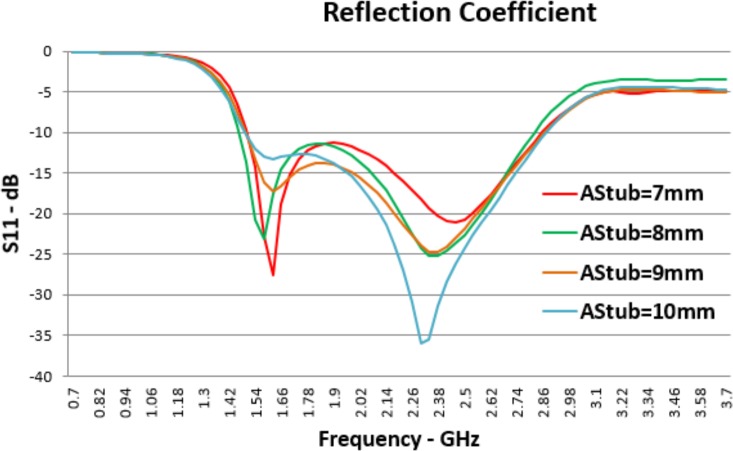
Effects of AStub Changes on Reflection Coefficient (S11).